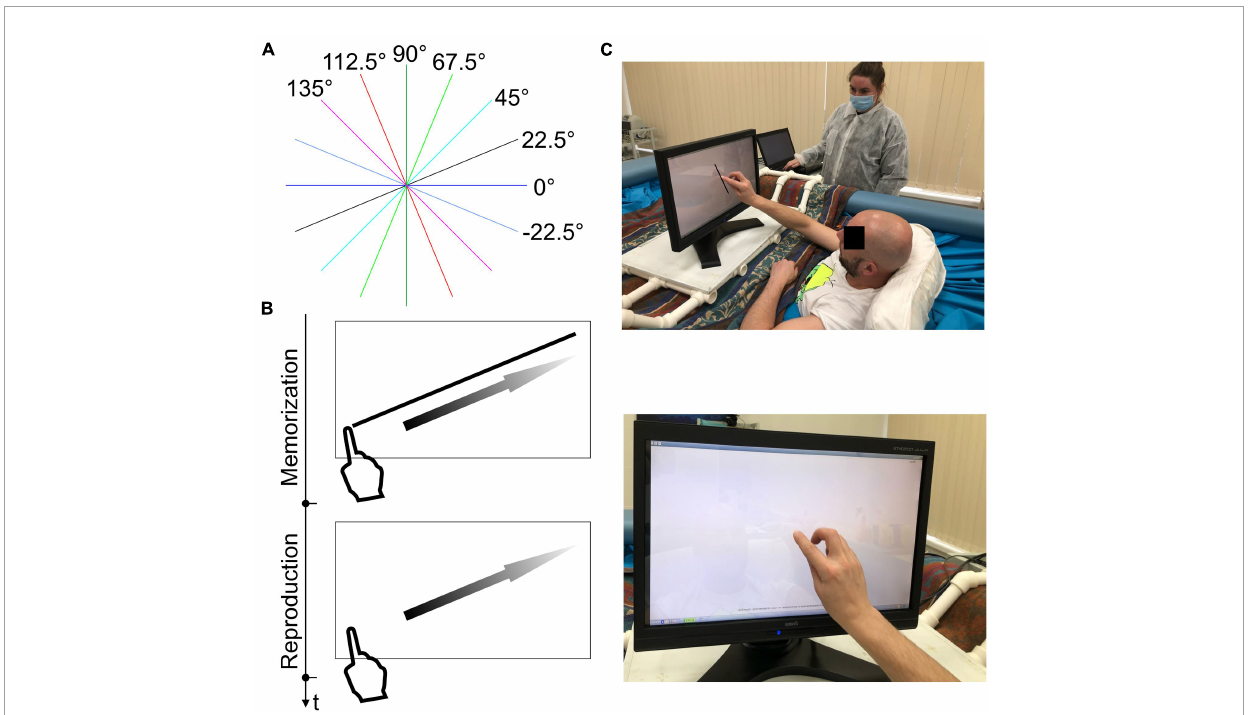
FIGURE1 Experimental design. (A) Stimuli material. One segment directed at the specified angle was presented in each probe (segments are colored for demonstration purposes). (B) In the memorization stage, the volunteer moved the index finger of his dominant hand over the segment. Then the experimenter pressed the button on the keyboard, the stimulus disappeared, and the volunteer reproduced the memorized parameters of the given segment at the same location on an empty screen. (C) Memorization and reproduction stages during dry